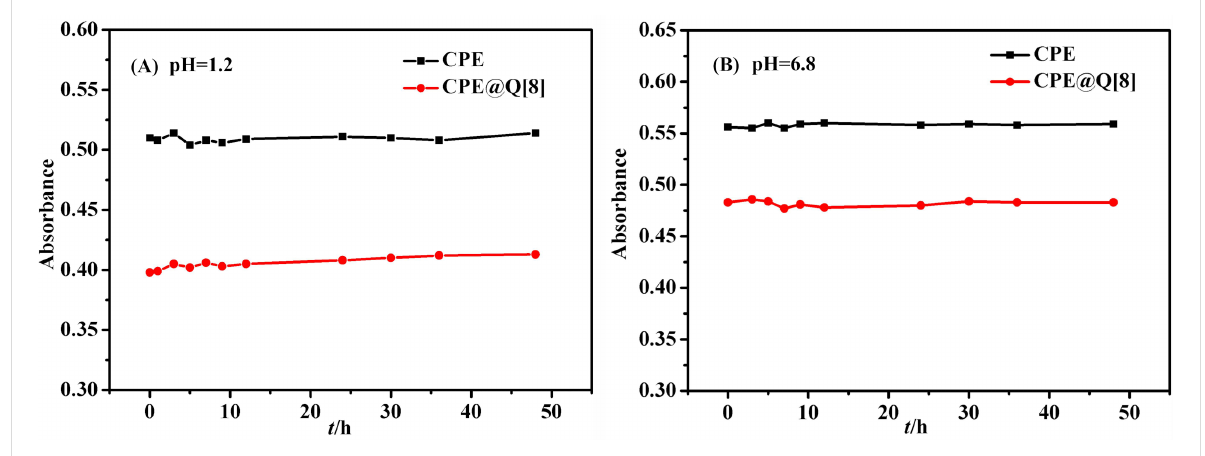
Figure 7: UV absorption intensity of CPE and CPE@Q[8] changes with time in the artificial gastrointestinal juice (pH 1.2, pH 6.8).